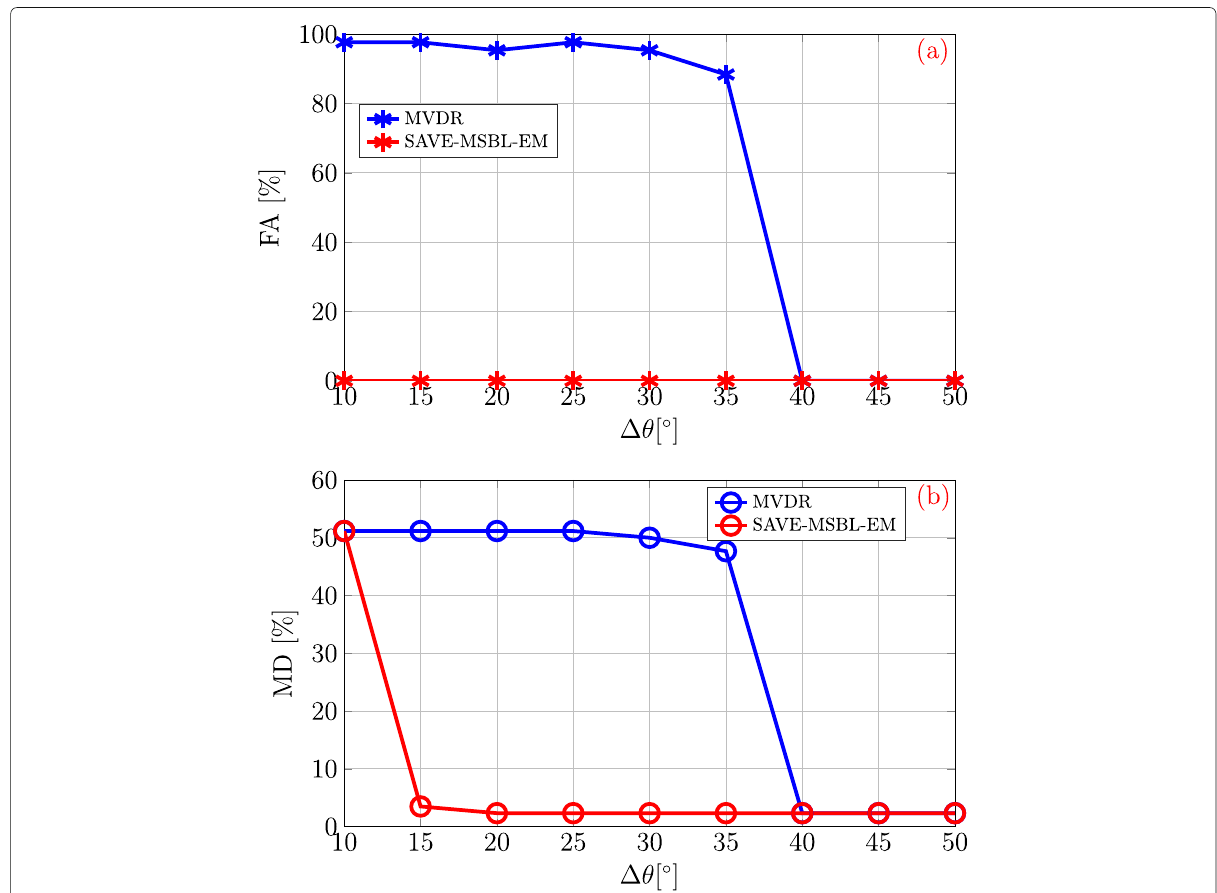
Fig. 10 Simulation results. a False alarm rate in low-reverberation environment. b Miss-detected rate in low-reverberation environment